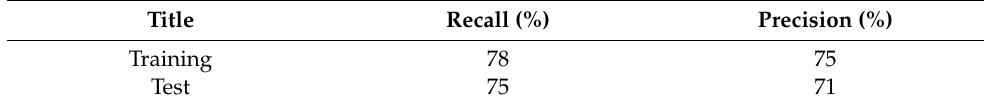
Table 6. Recall and precision rates for training and test.